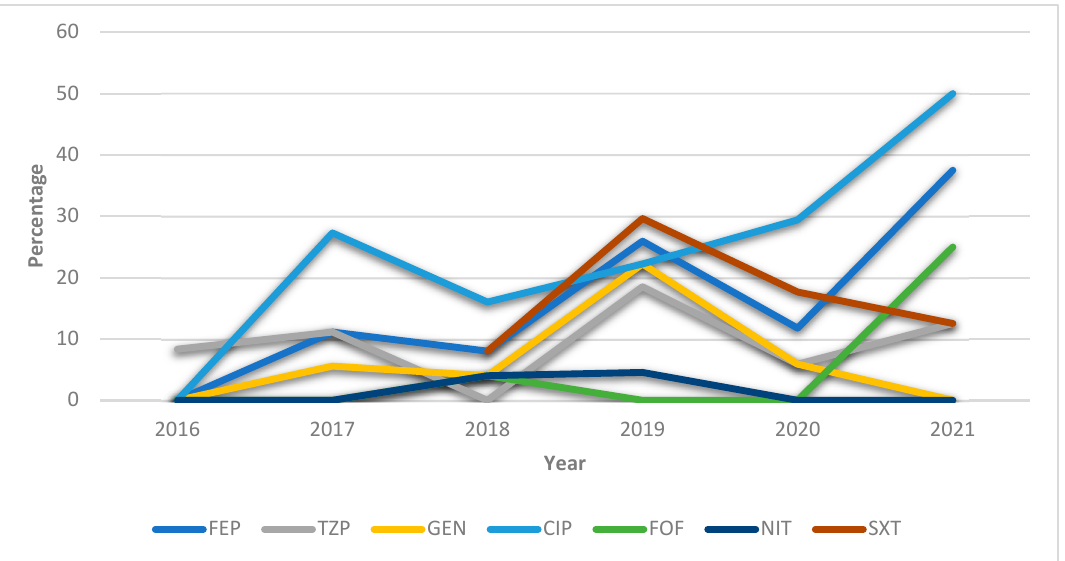
Figure 4. General annualized resistances (%) of Citrobacter freundii between 2016 and 2021 against the antibiotics most frequently used to treat UTIs. FEP = cefepime; TZP = piperacillin–tazobactam; GEN: gentamicin CIP = ciprofloxacin; FOF = fosfomycin; NIT = nitrofurantoin; SXT = trimethoprim– sulfamethoxazole.